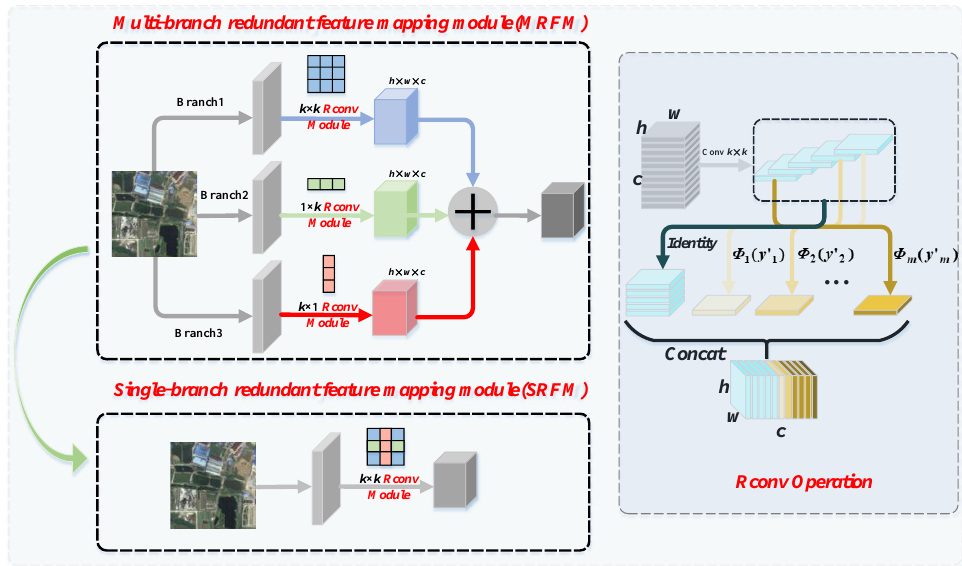
Figure 2. Illustration of the redundant feature mapping module. Specifically, the redundancy mapping module consists of three aspects: the multi-branch redundancy mapping module (MRFM), the single-branch redundancy mapping module (SRFM), and the redundancy mapping convolution (Rconv) operation. It is worth noting that the single-branch redundancy mapping module is generated from the multi-branch redundancy mapping module after BN fusion and branch fusion